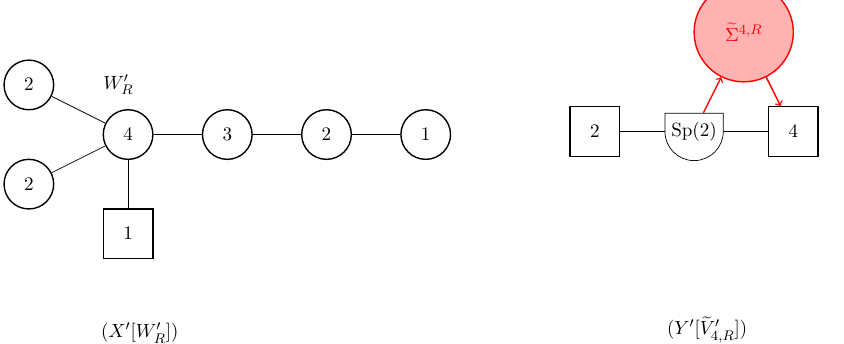
Figure 41 . The construction of a Wilson defect in the bifurcated quiver gauge theory X 0 , labelled by a representation R of the gauge node U(4) . It is dual to a vortex defect in the theory Y 0 (an Sp(2) gauge theory with N = 6 ), realized by a 3d-1d system labelled by the representation R for f U(4) . The Witten index of the SQM in ( Y 0 [ e V 0 ]) should be computed in the chamber ξ < 0 . 4 ,R